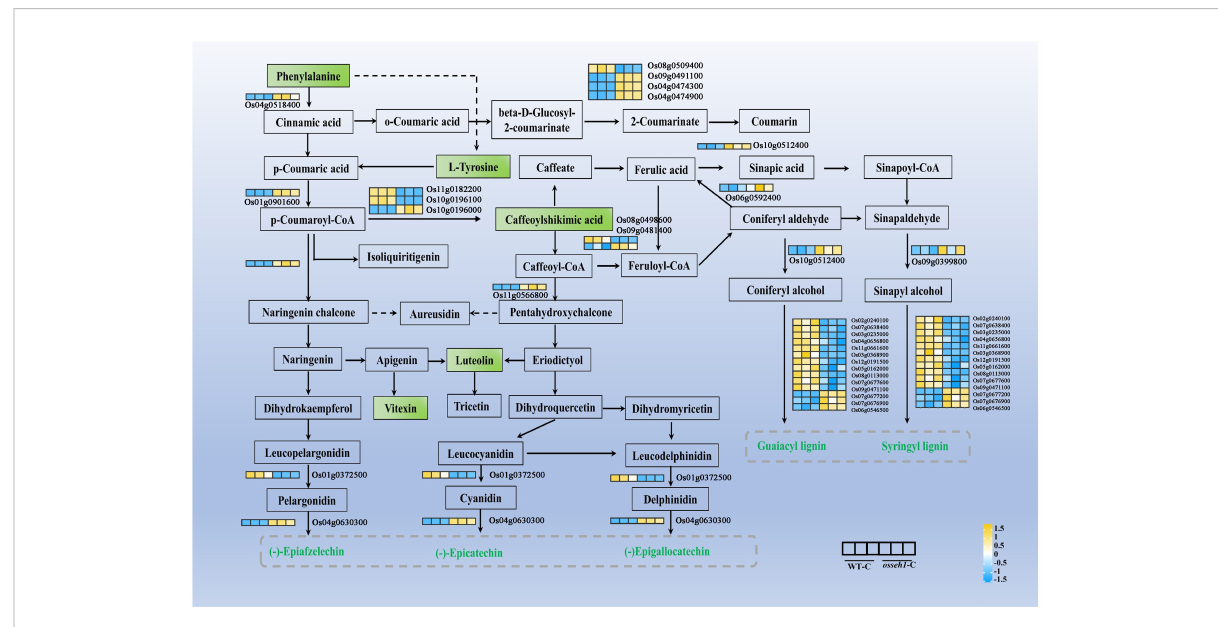
FIGURE 7 Different accumulation and expression patterns of metabolites and genes related to the phenylpropanoid biosynthesis pathway. Rectangle in the pathway indicates metabolite. The differentially accumulated metabolites are shown in green. The expression levels of genes are shown from yellow to blue (high to low) in the comparison of WT-C vs. osseh1 -C. Gene heatmap shows the value of Log 2 (FPKM) in WT (left panel) and osseh1 knock-out lines (right panel). WT-C, WT under cold treatment. osseh1 -C, osseh1 lines under cold